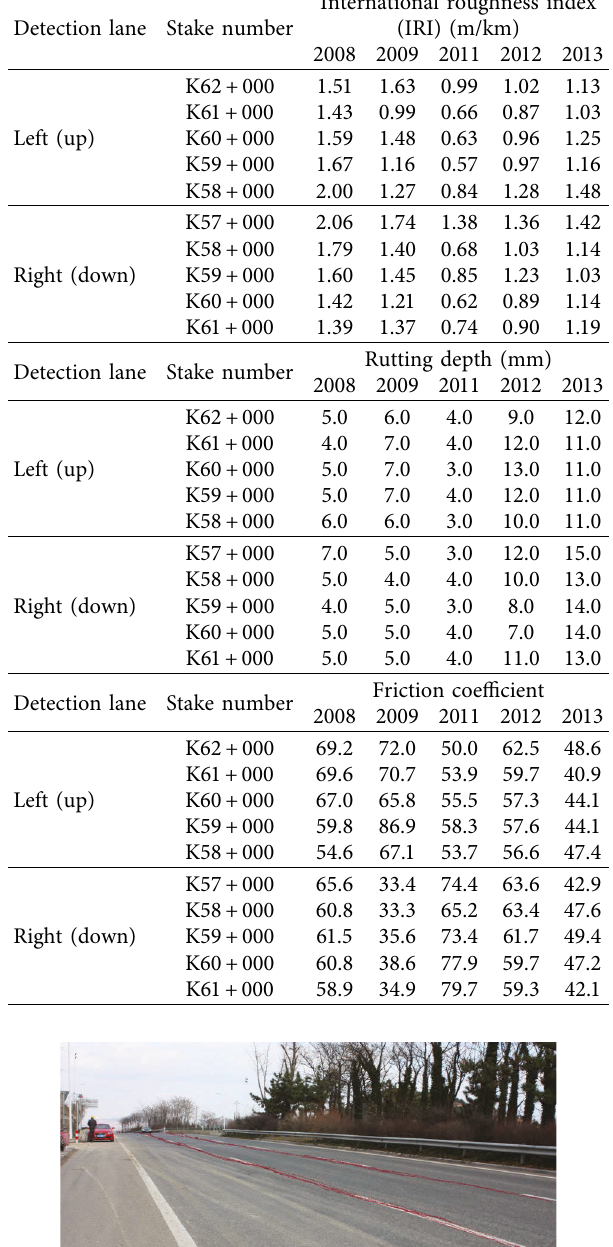
Table 1: Distress investigation results of Yangkou tunnel.